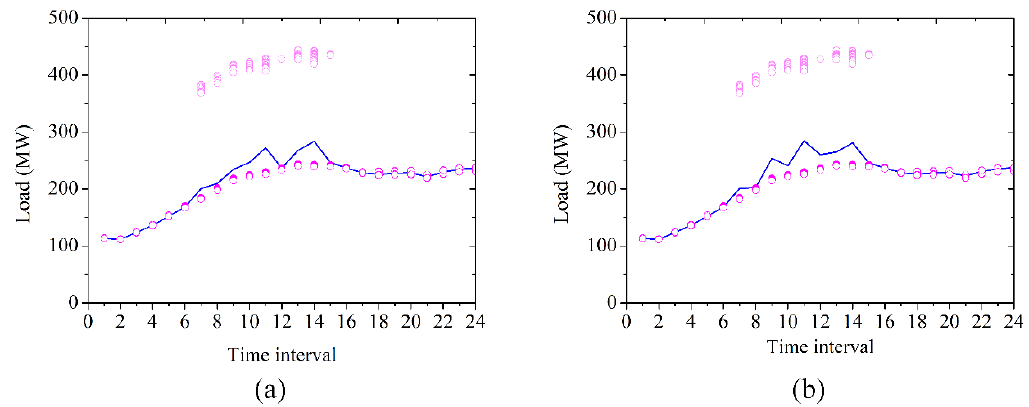
Figure 6. The load characteristics ( a ) without road-block and ( b ) with road-block.